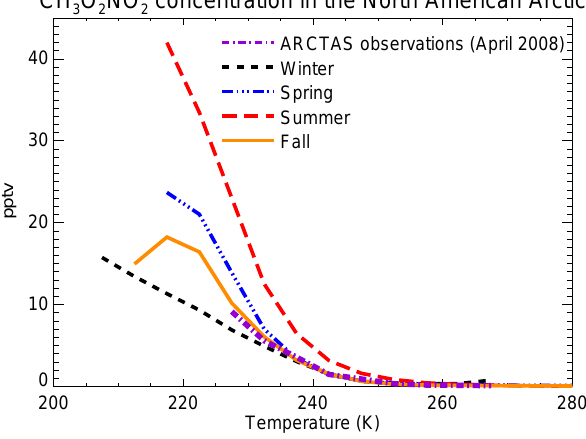
Fig. 3. Temperature binned mean values of the GEOS-Chem mod- eled CH 3 O 2 NO 2 24h average concentrations over the North Amer- ican Arctic for each